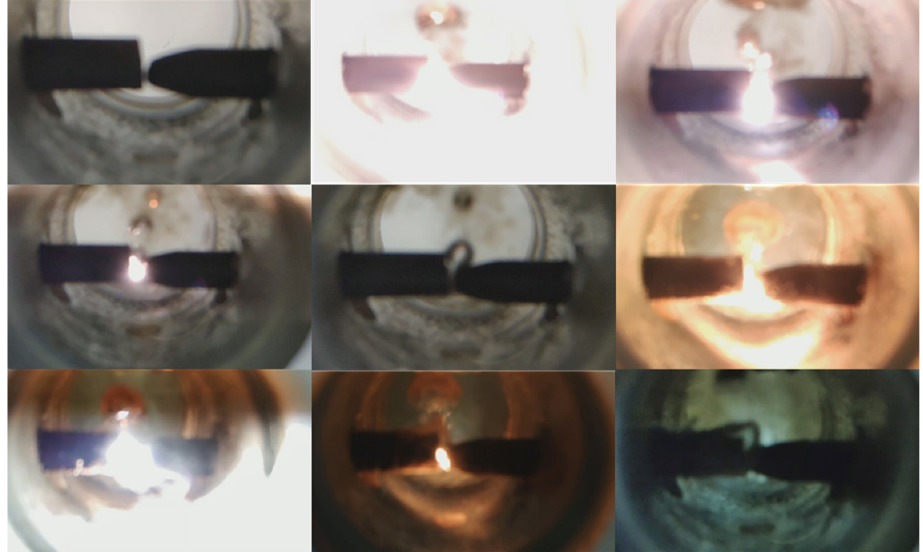
Figure 4. Photos of pulsed discharges in the liquid phase.